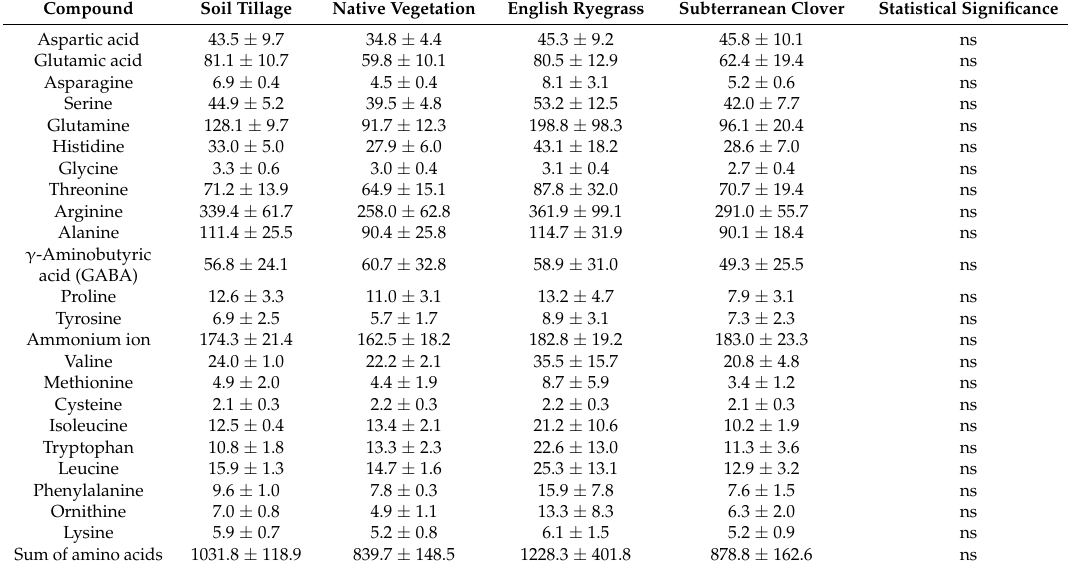
Table 3. Soil management effects on the amino acid concentrations (mean ± standard error, mg L − 1 ) of musts from Menc í a averaged for three seasons (2012–2014). Compound Soil Tillage Native Vegetation English Ryegrass Subterranean Clover Statistical Significance Aspartic